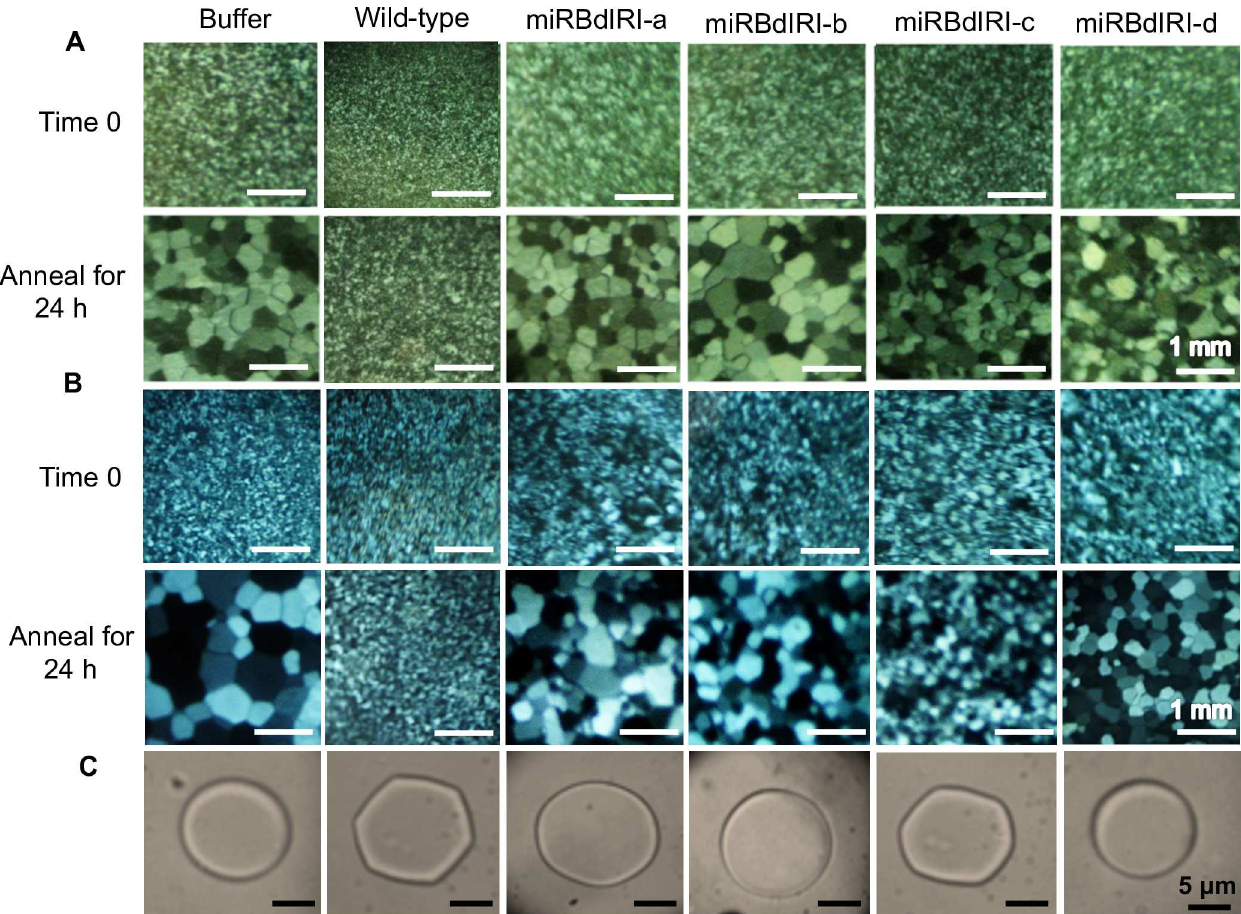
Fig 10. Ice-binding activities in wild-type B . distachyon and transgenic knockdown lines (miRBdIRIs). Ice-recrystallizationinhibitionwas assayed in buffer controls and crude cell lysates (A) as well as apoplast extracts (B), from wild-type plants and knockdown lines (miRBdIRIa-d) after annealingat − 4˚C for 24 h, at a total protein concentration of 0.1 mg/mL. Ice crystal morphologies (C) were tested at 0.5 mg/mL of total protein collectedfrom crude cell extracts. All assays were performed in triplicate.